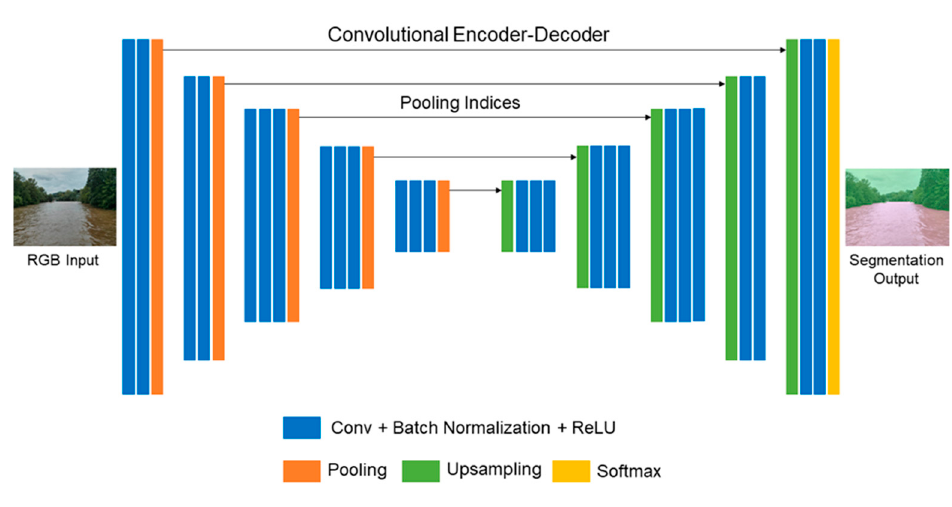
Figure 3. An illustration of SegNet architecture [60].